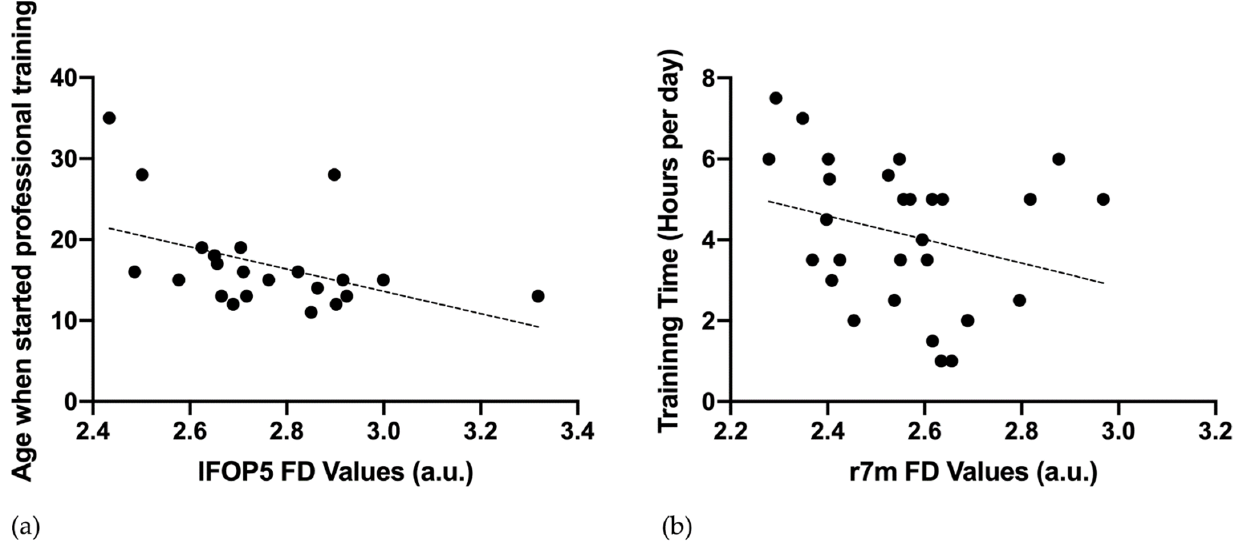
Figure 3. Scatter plots of fractal dimension (FD) values and demographic and behavioral data among professional chess players. ( a ) The FD in the left frontal operculum OP5 (lFOP5) is correlated with the age (years) at which the participants begin their professional training ( ρ = − 0.503, p = 0.008). ( b ) The FD in the right area 7M (r7m) is correlated with the daily time spent in chess training ( ρ = − 0.403, p = 0.034). a.u. = arbitrary units.